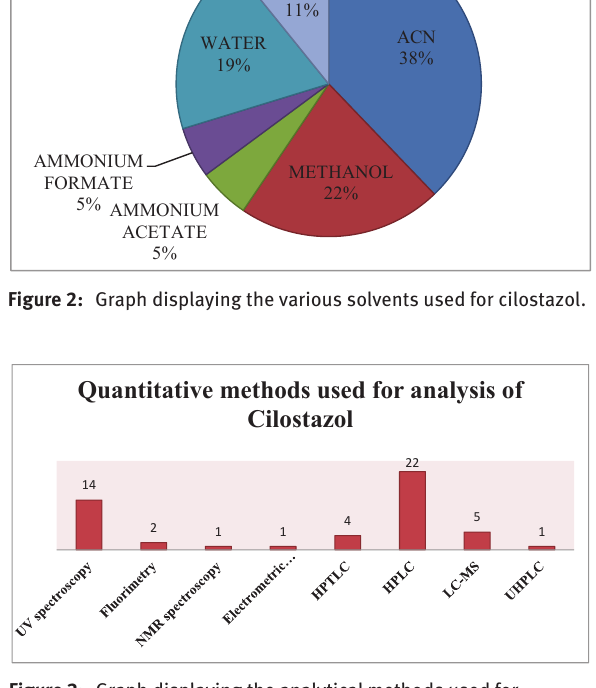
Figure 3: Graph displaying the analytical methods used for determination of